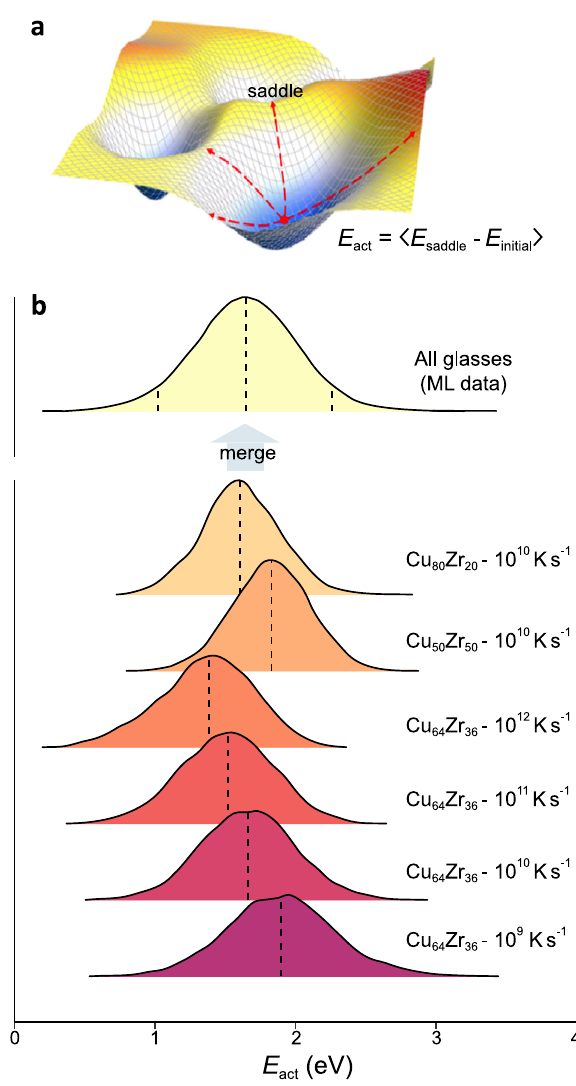
Fig. 1 Thermally activated events in Cu-Zr metallic glasses. a Schematic description of the β -process in the context of potential energy landscape (PEL). Red dashes illustrate several activated pathways from a local minimum. In practice, we initiate 50 independent events around each atom along random activation pathways using ART and extract an ensemble-averaged activation energy E act for each atom. b Distribution of E act in the six model glasses as well as their combined E act spectrum. The median (quantile 50%) and quantiles 5% and 95% are marked as vertical dashed lines in the combined E act spectrum, and the median (quantile 50%) is marked in the spectrum of each model